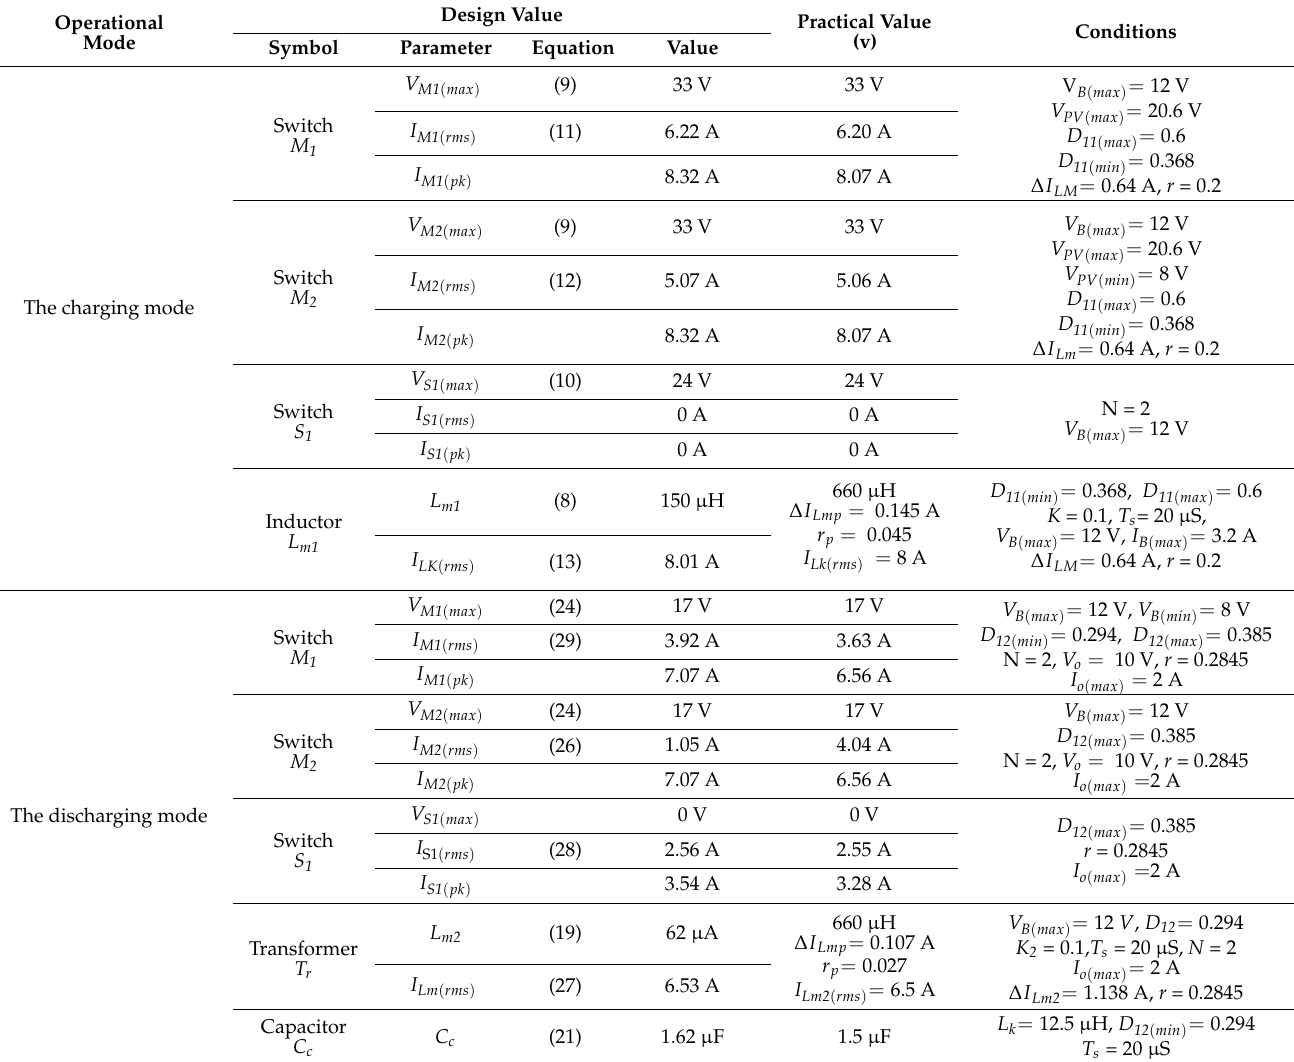
Table 4. Parameters of components in the proposed hybrid converter.